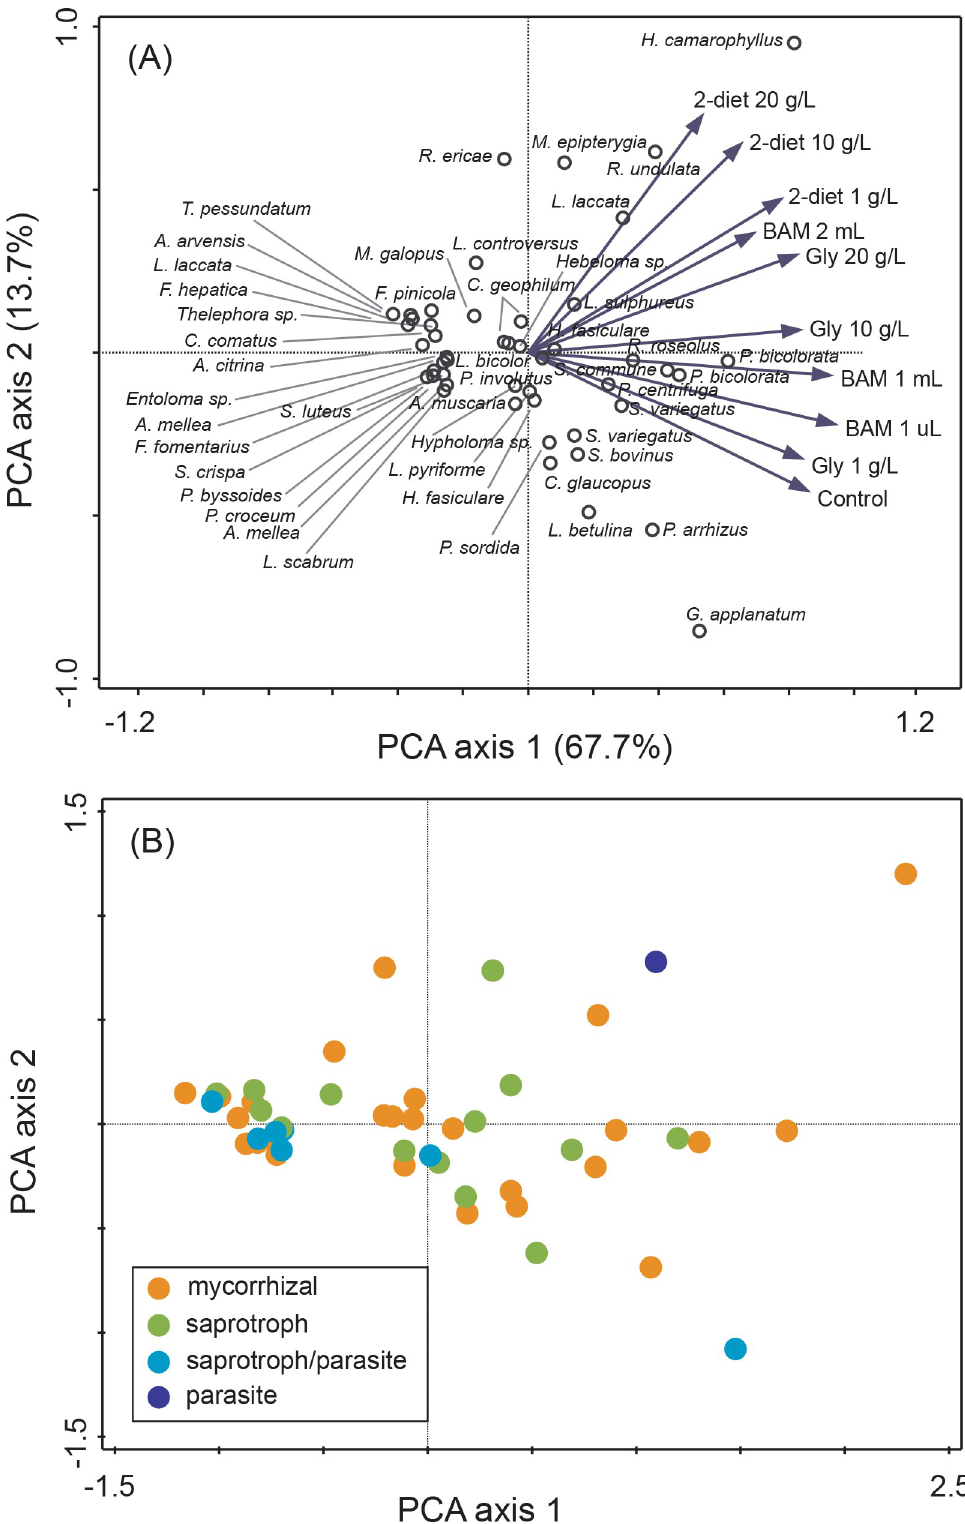
Fig 5. Overall fungal biomass responses to the three tested N-containing recalcitrant compounds in the screening experiment. Principal component analysis (PCA) showing the variation in biomass responses for 48 fungal isolates